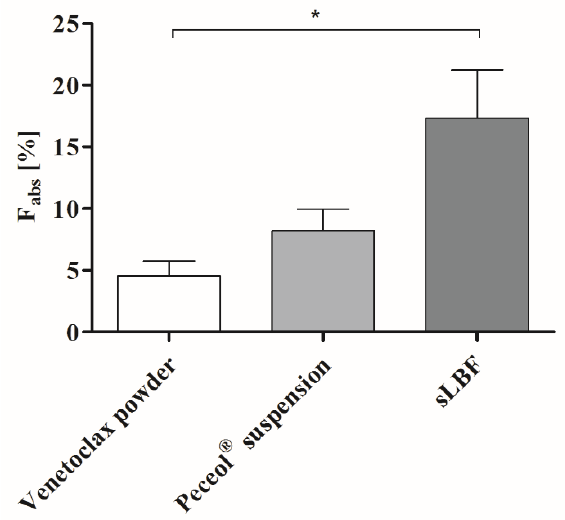
Figure 6. Absolute bioavailability (F abs ) of 100 mg venetoclax as a venetoclax powder capsule, a Peceol ® suspension, and a supersaturated Peceol ® solution (sLBF) in male landrace pigs. All data is presented as the mean ± SD, where n = 3 (except for sLBF, where n = 2). Statistical difference is indicated as *, where p ≤ 0.05.